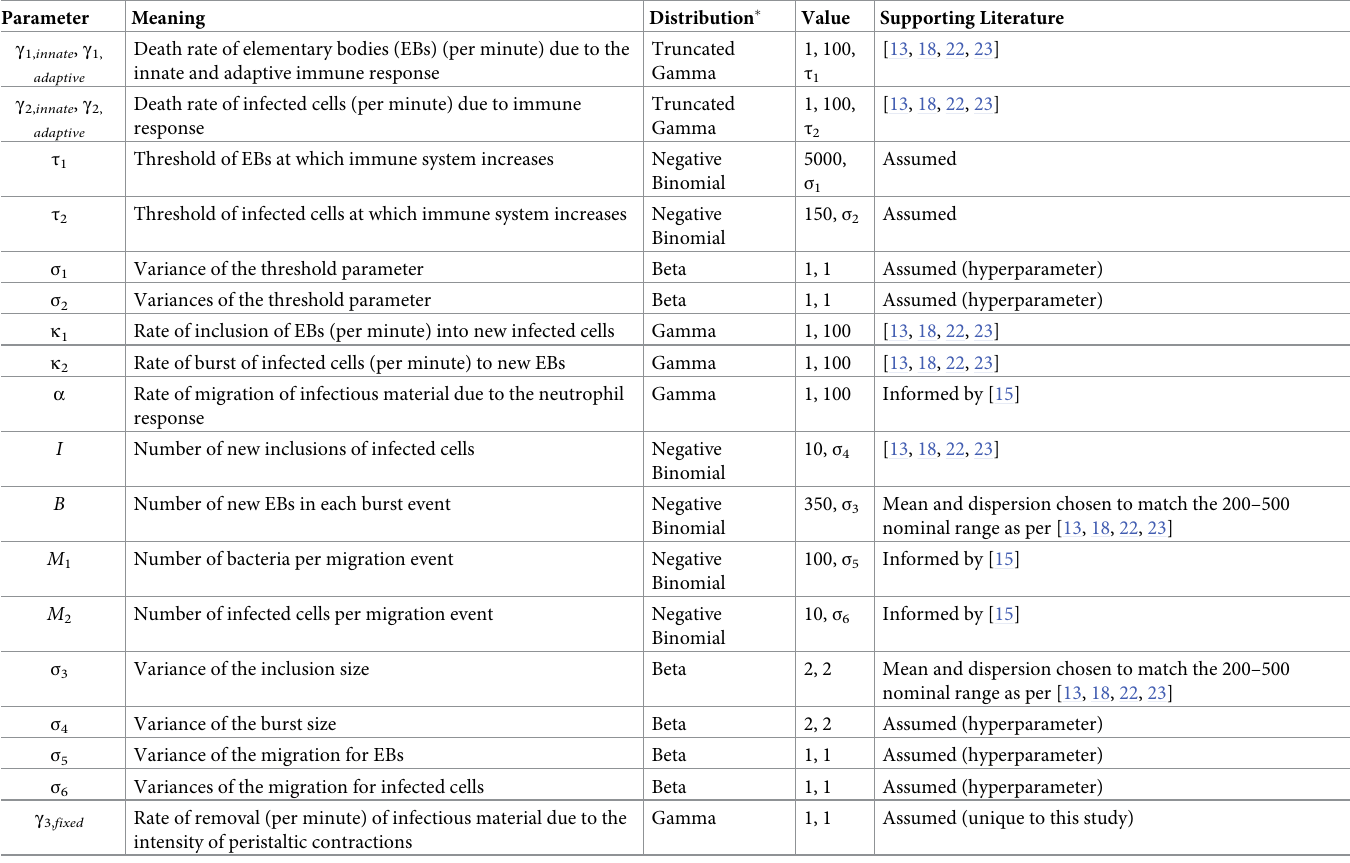
Table 1. Parameters incorporated in the model and values assigned for this